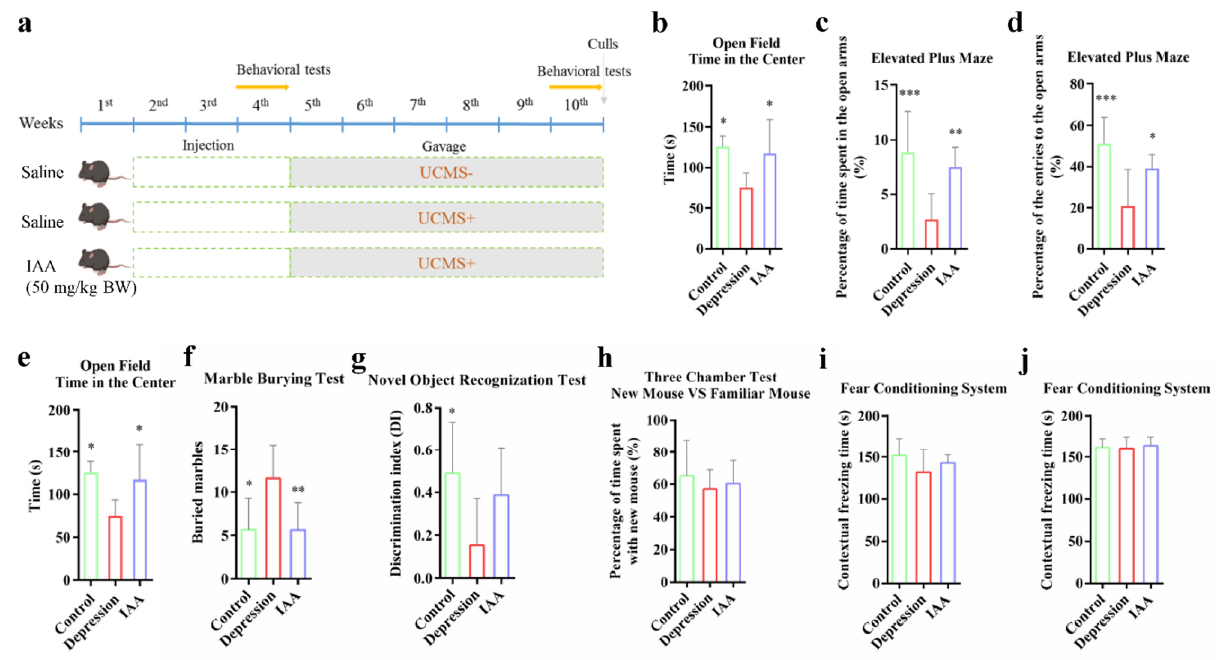
Figure 1. Experimental design and results of the behavioural tests. ( a ) Schedule of C57BL/6J mice treatment during 10 weeks. ( b – j ) Evaluation of anxiety-like, depression-like, social behaviours and cognition in mice treated with UCMS and IAA. One-way ANOVA with Tukey’s post-test was used. Compared with the depression group, * p < 0.05, ** p < 0.01, *** p < 0.001.